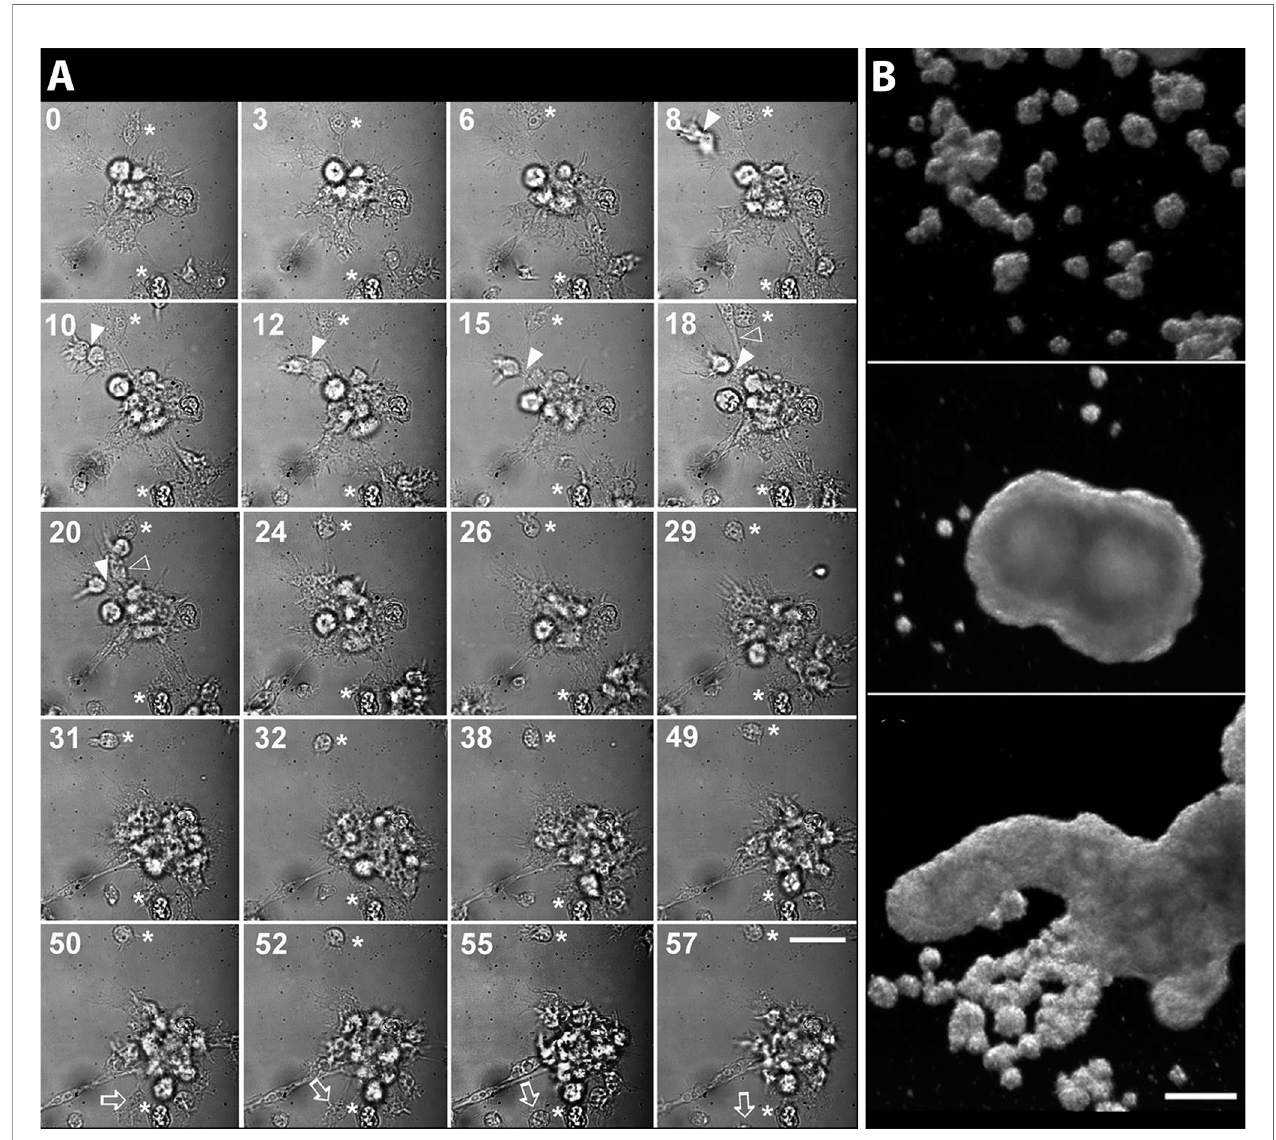
FIGURE 8 | Circulating hemocytes of P. canaliculata in culture. (A) Dynamics of an early aggregate formation by time-lapse video-microscopy. Time elapsed after seeding (in minutes) is shown in the upper-left corner of each selected frame. Arrowheads indicate two cells together which are approximating the larger aggregate and fi nally merge with it (8 – 20 min). Open arrowheads show an elongated cell which rapidly joins the aggregate (18 – 20 min). Open arrows point to a cell which detaches from the aggregate and leaves the observation fi eld (50 – 55 min). Also, a smaller cell aggregate appears in the lower right corner approximating the larger aggregate and fi nally joining it (18 – 31 min). Asterisks indicate two cells which appear attached to the substrate and did not move during all the period of observation (0 – 57 min). Scale bar represents 20 µm. (B) Hemocyte aggregates formed in culture and merging into large fl oating masses (phase contrast, micrographs taken 96 h after seeding). Scale bar represents 200 µm (all panels). From